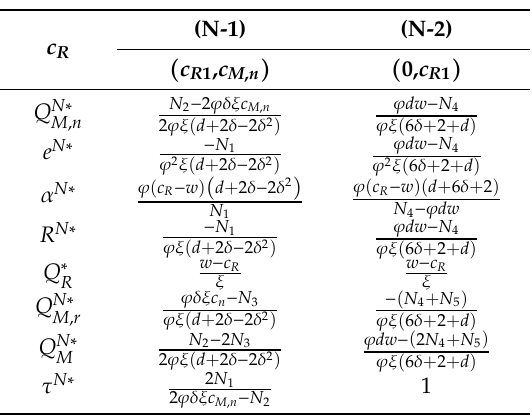
Table 2. The optimal solutions under model N.